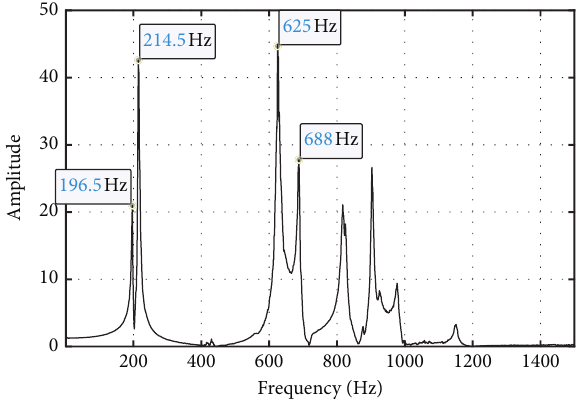
Figure 7: FTF for cargo bolts in damage case ② .